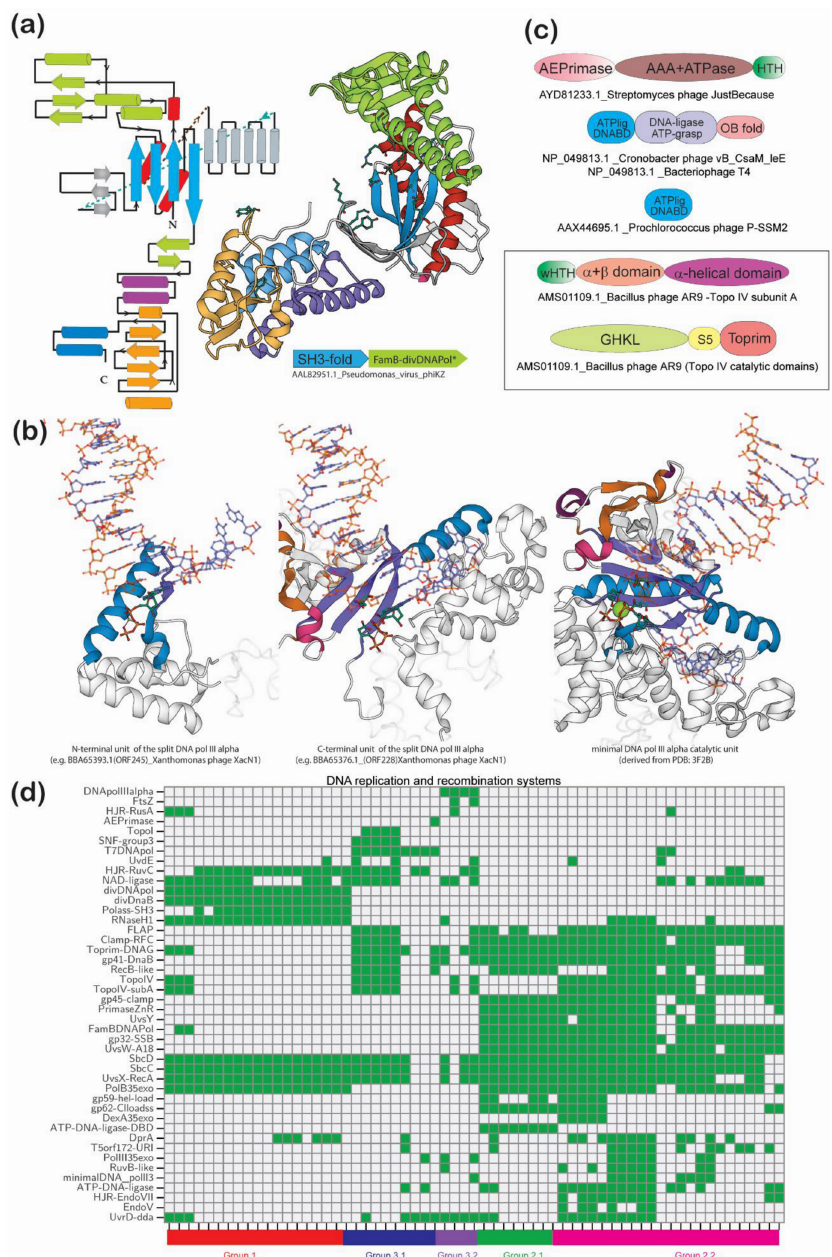
Figure 3. DNA replication and recombination systems of jumbo phages. ( a ) Predicted topology diagram, cartoon structure, and most common gene neighborhood of the divergent DNA polymerase of group 1. In the topology diagram, helices are shown as cylinders and strands as arrows. The cartoon structure was rendered using the MOL* program. Corresponding secondary structure elements are colored similarly in the topology diagram and cartoon. Genes are represented as boxed arrows with arrow-heads pointing to the 3 (cid:48) ends of the gene. The accession number in the label corresponds to the gene marked with a *. ( b ) Predicted components of the split DNA Polymerase III catalytic α subunit. The N-terminal unit is shown on the left and the C-terminal in the middle. ( c ) Domain architectures of some interesting proteins involved in DNA replication and recombination. Proteins are denoted by their accession numbers and phage names separated by underscores. ( d ) Phyletic vector diagram of various replication and recombination proteins in a sample of jumbo phages. The Canberra distance and Ward clustering were used to determine protein and species order in the matrix. Filled green squares indicate presence of a gene. The phage name order is the same as in Figure 4 in all vector diagrams in the main